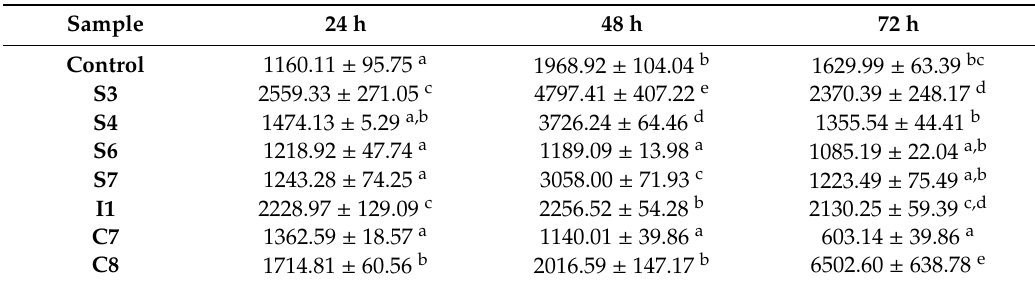
Table 5. Antioxidant activity ( µ M Trolox equivalent) of waste broth with 2% glucose fermented by the selected bacteria at 37 ◦ C for 24, 48, and 72